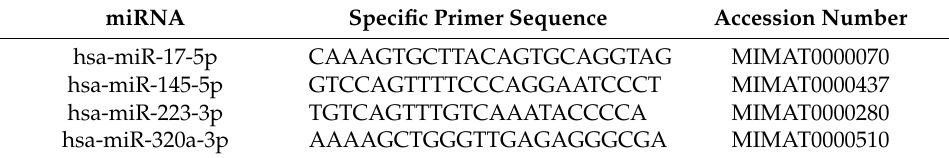
Table 1. Sequences of primers used for detection of